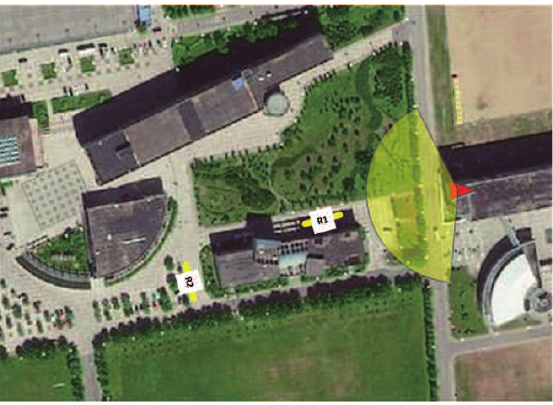
Figure 1. Measurement map (Red triangle is the Tx location. R1 and R2 are the measurement routes in LoS and NLoS conditions,